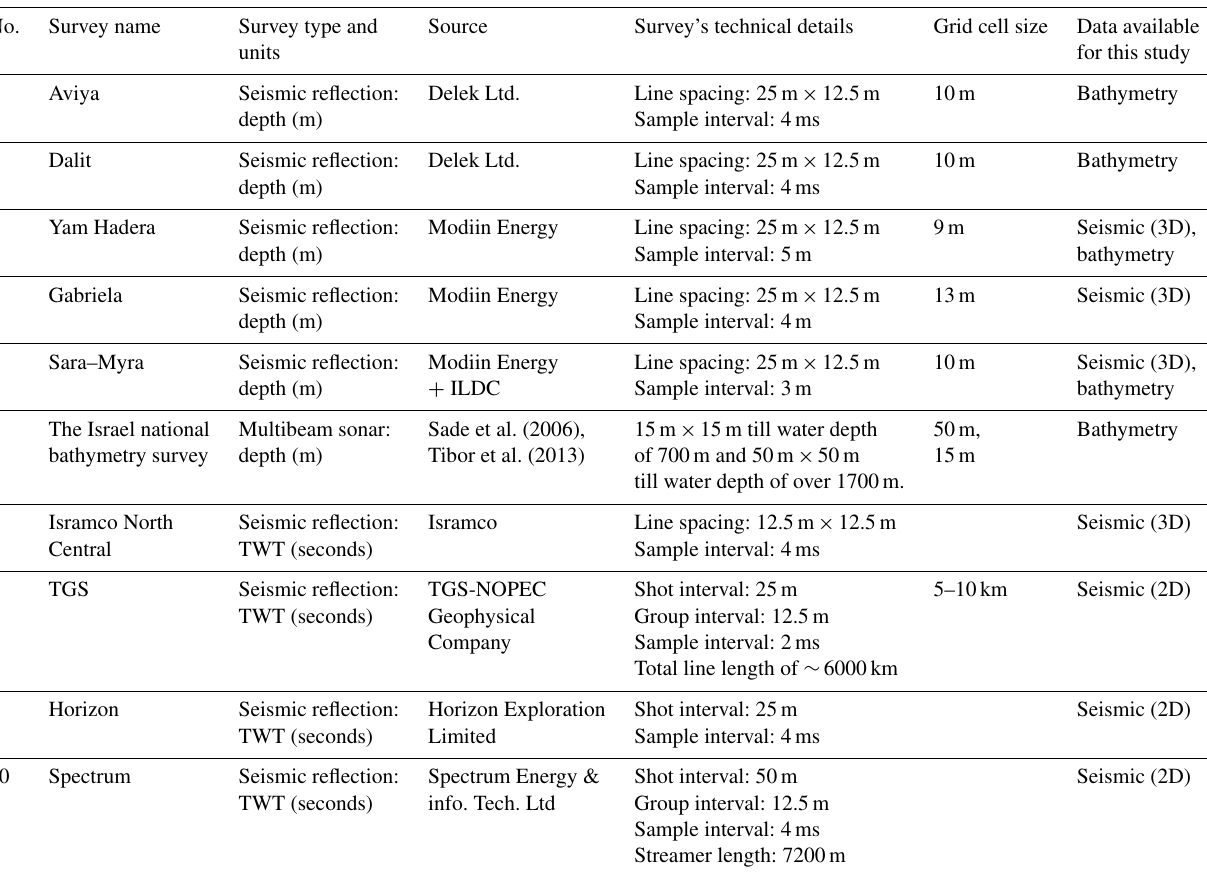
Table 1. Seismic